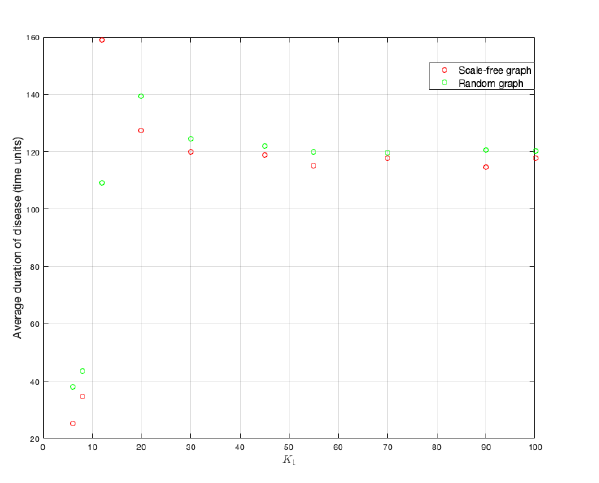
Figure 14. Average end of disease for different K 1 in random and scale-free graph.